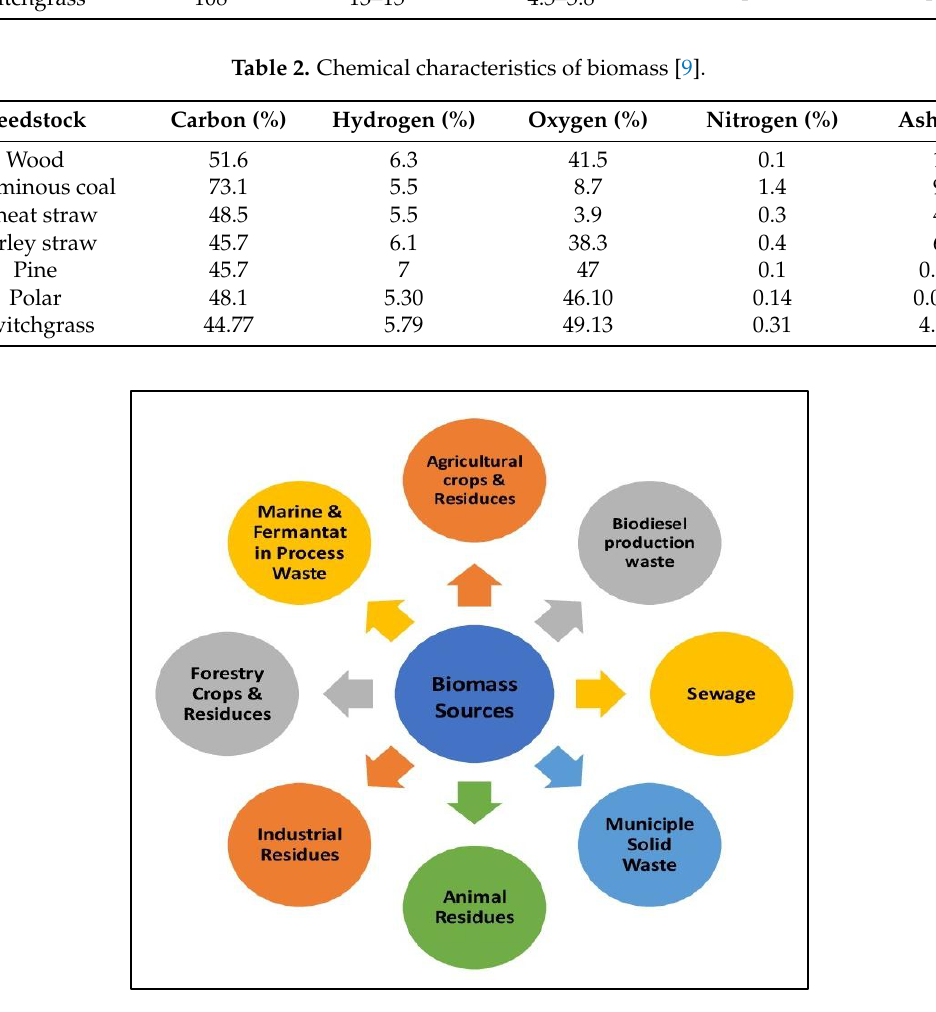
Table 2. Chemical characteristics of biomass [9].